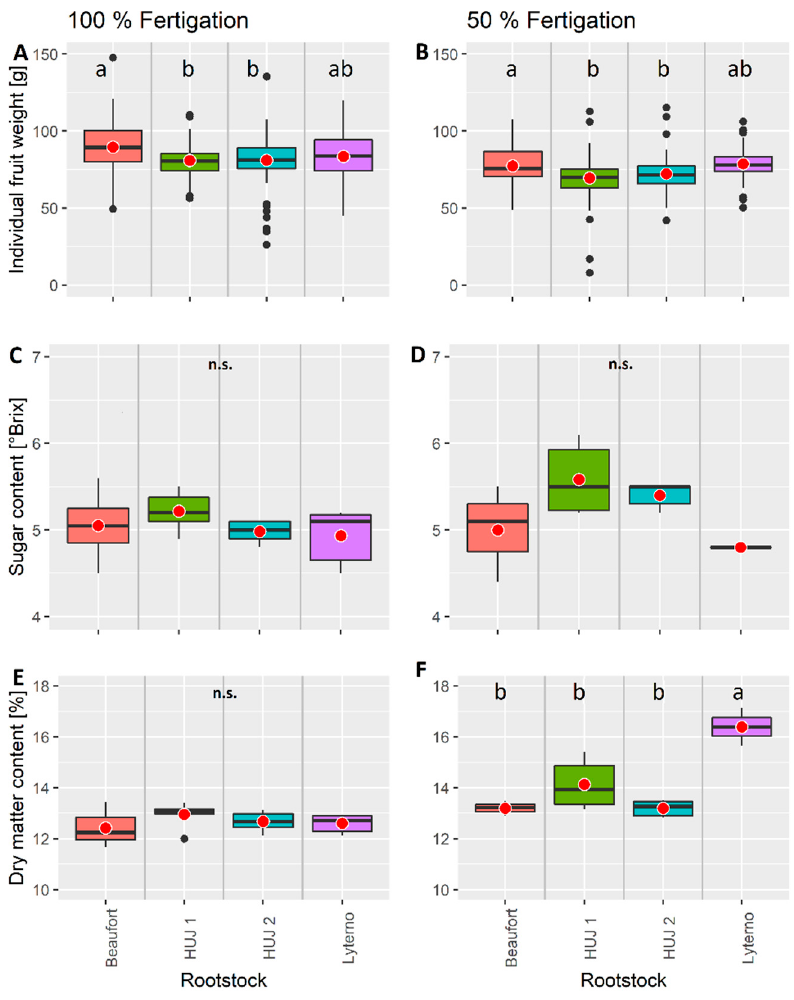
Figure 3. Quality parameters of ‘Lyterno’ fruits grafted onto four different rootstocks and supplied with optimal ( A , C , E ) and reduced ( B , D , F ) fertigation: Individual fruit weight (g) (n = 49–84), ( A , B ); total soluble solids (‘sugar’) content of ripe fruits (°Brix) (fruits of n = 2–6 plants), ( C , D ); fruit dry matter content [%]; (n = 2–6) ( E , F ). n.s.: not significant, p -value